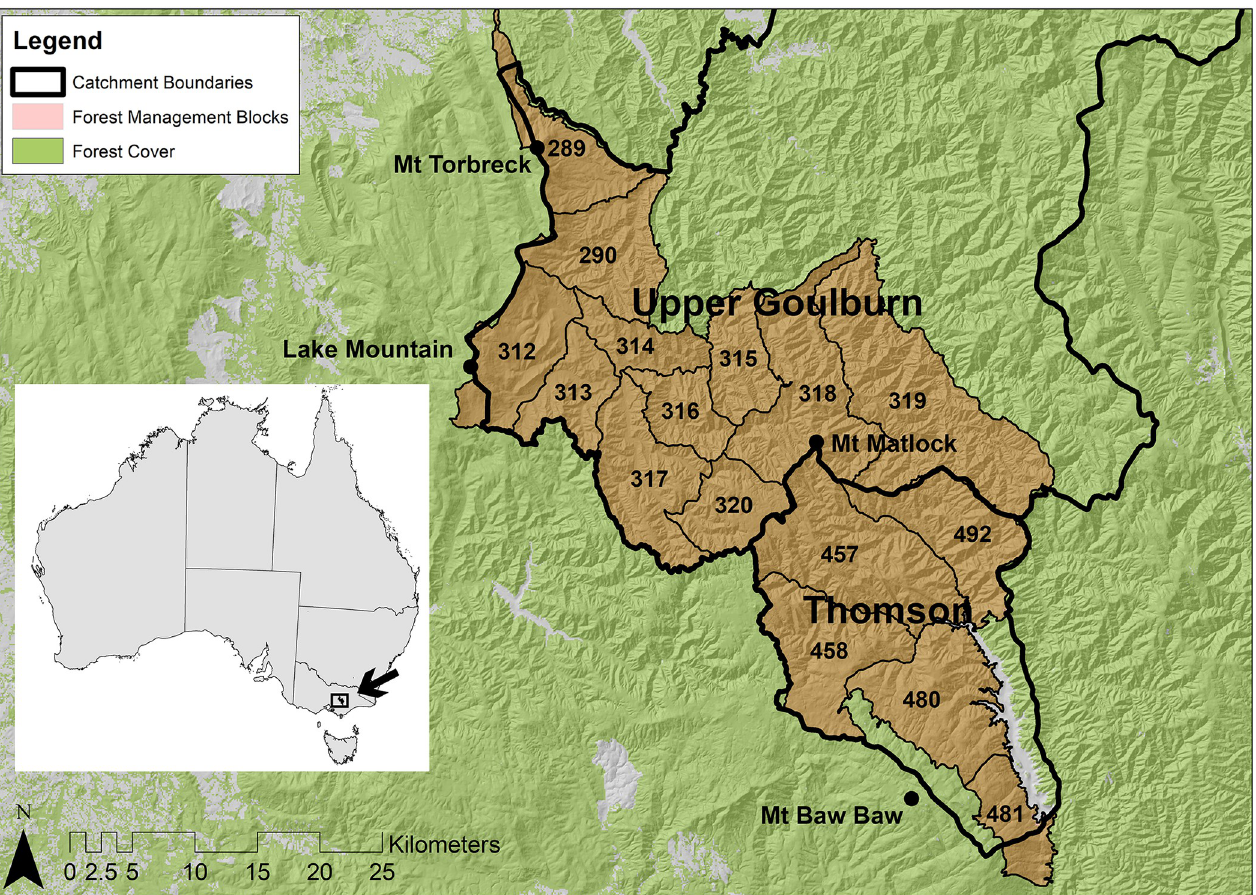
Fig 1. Location of study area consisting of forest management blocks (identified by number) across the Upper Goulburn and Thomson water supply protection areas.